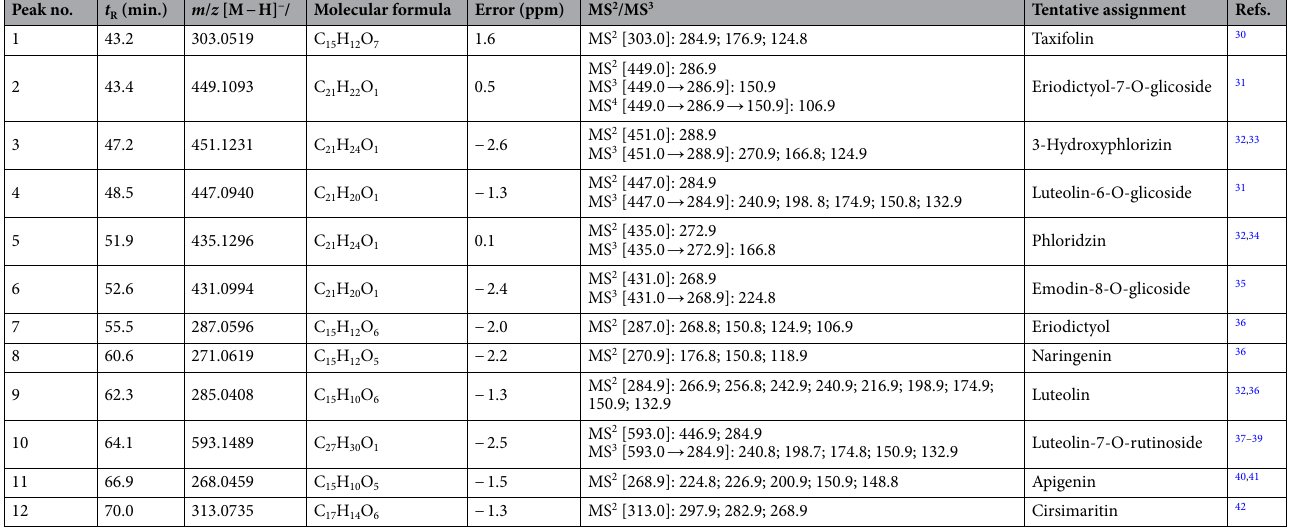
Table 1. Negative MS fragmentation and UV–vis absorption data of the compounds detected in L. sidoides